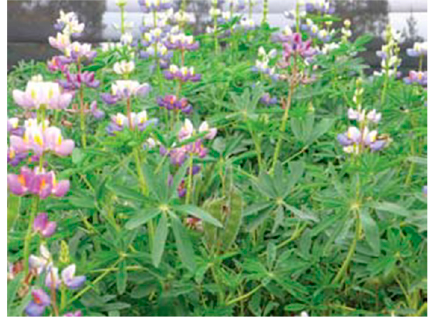
Figure 5. Lupinus mutabilis (pearl lupin) Photo: P. White.